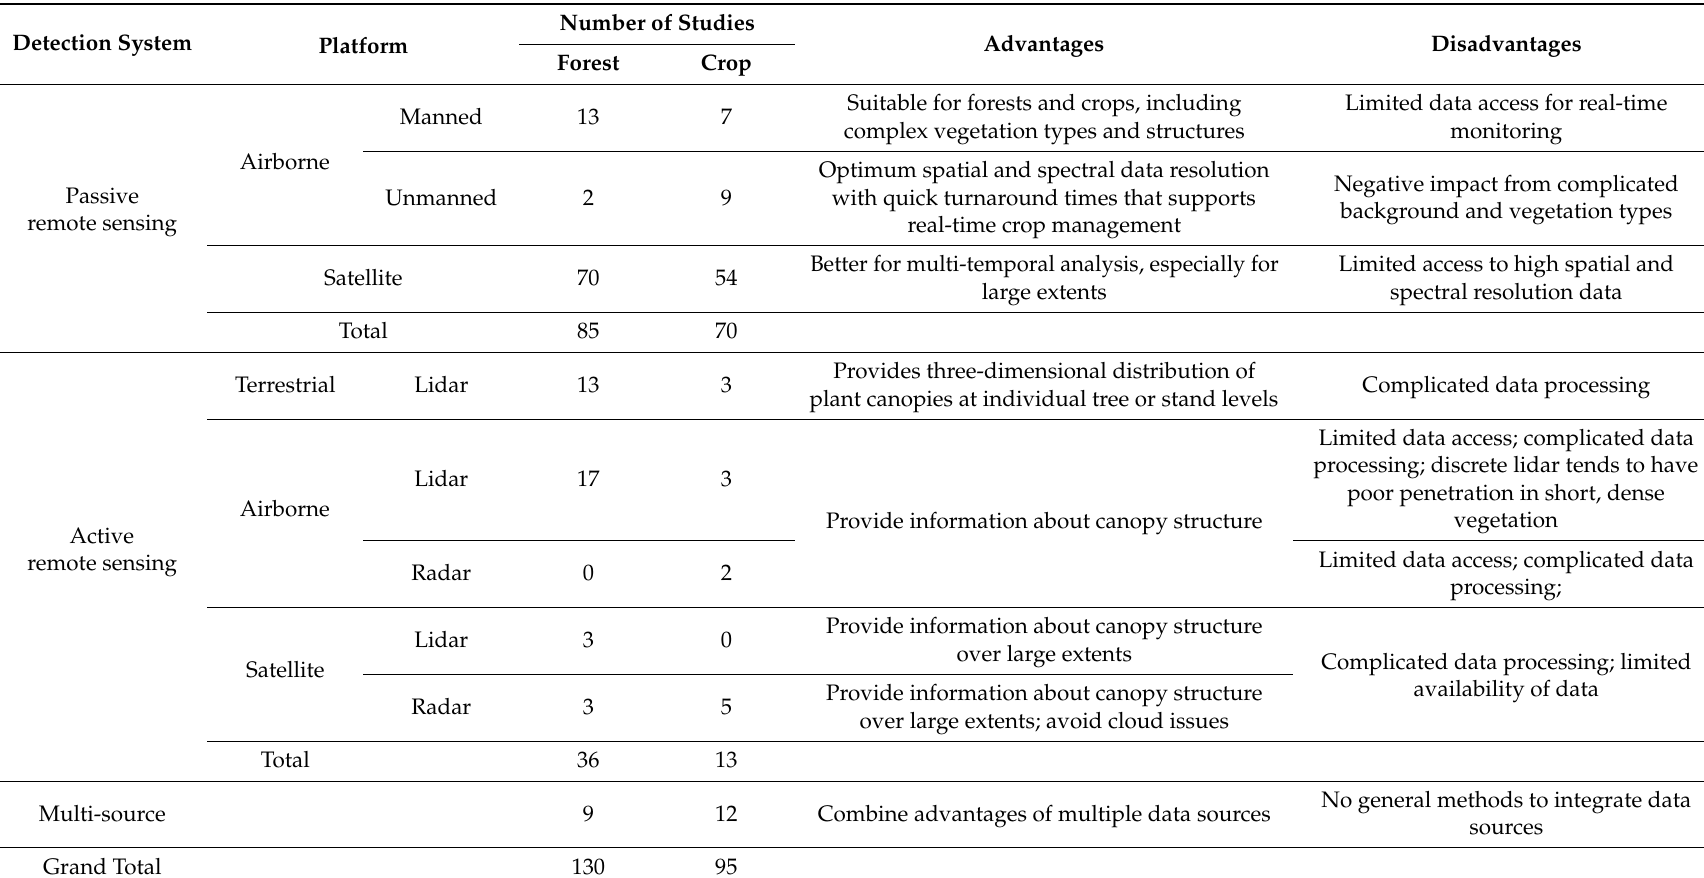
Table 2. Summary of the application of types of di ff erent detection systems and platforms used to estimate LAI in forest and crops from